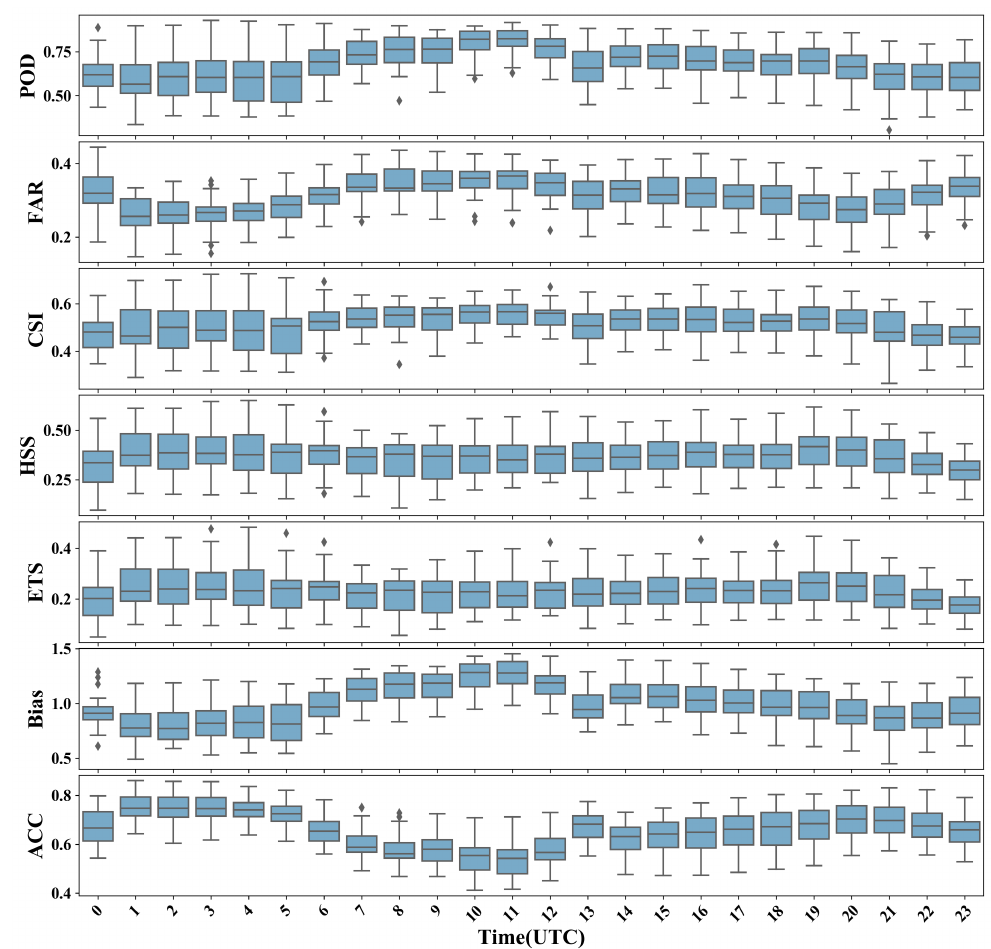
Figure 19. The diurnal variation of evaluation scores for rain area determination and precipitation grades estimation on RF model against gauge stations during August 2018, distributions of statistical values at one hour intervals are interpreted in box plots. Box diagrams indicate the 25th, 50th, and 75th percentiles, whereas the periphery of the box extends to 1.5 times of the quartile deviation (25th–75th percentile). Outliers are indicated by black